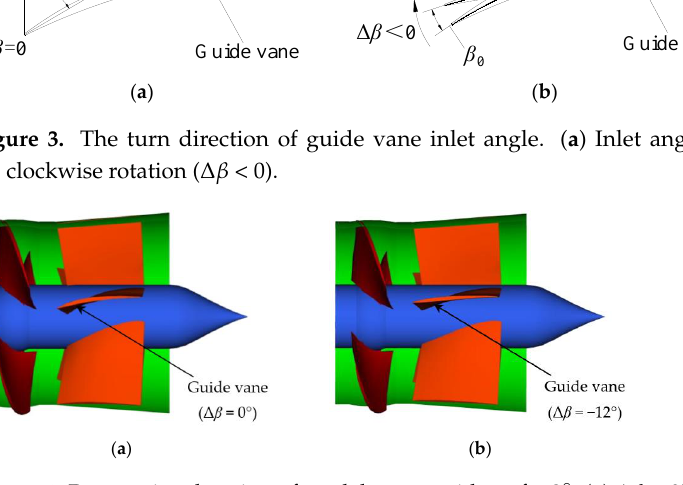
Figure 4. Perspective drawing of model pump with α of − 2 ◦ , ( a ) ∆ β = 0 ◦ , ( b ) ∆ β = − 12 ◦ .